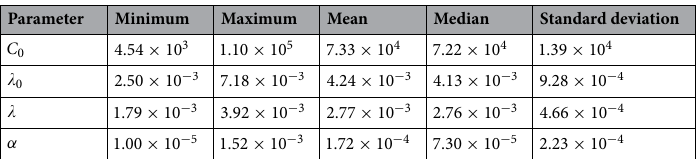
Table 6. Summary statistics for the posterior distributions of the exponential model for the F5